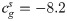
Comparison of the spread rate for stochastic, sample-averaged, and grand-averaged dispersal kernels.Panels (a) and (b) are a scenario with only good years (featured by some northward dispersal), and panels (c) and (d) are a scenario with a mixture of good and bad years (the latter featured only southward dispersal). See text for explanation of the symbols associated with the spread rate c. Each point in the scatterplots in panels (a) and (c) represents a pair of simulated spread rates, averaged and stochastic, for a given random sample (a 30-year sequence of dispersal kernels or parameters; see S2 Fig and S1 Table). If a point is above the solid line, then the stochastic spread rate is greater than the corresponding averaged rate. The dashed line indicates the spread rate resulting from the grand-averaged dispersal kernel (S2 Fig), which has the value cg = 21.5 km y-1 in panel (a) and cgs=−8.2 km y-1 in panel (c). The box plots in panels (b) and (d) present the differences between the different types of modeled spread rates (stochastic, sample-averaged and grand-averaged). The other model parameters were fixed as bA = 0.8, r = 23 adult female offspring per female per year, T1 = 50 d and T2 = 90 d for all simulations.